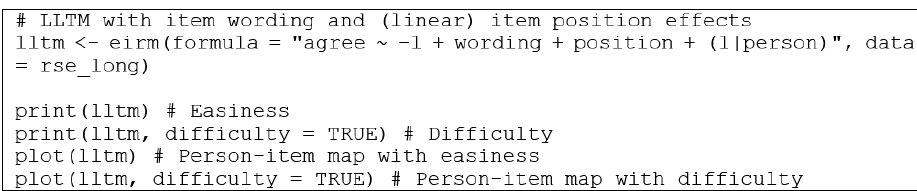
Figure 6. Estimate the LLTM model and print the model output.